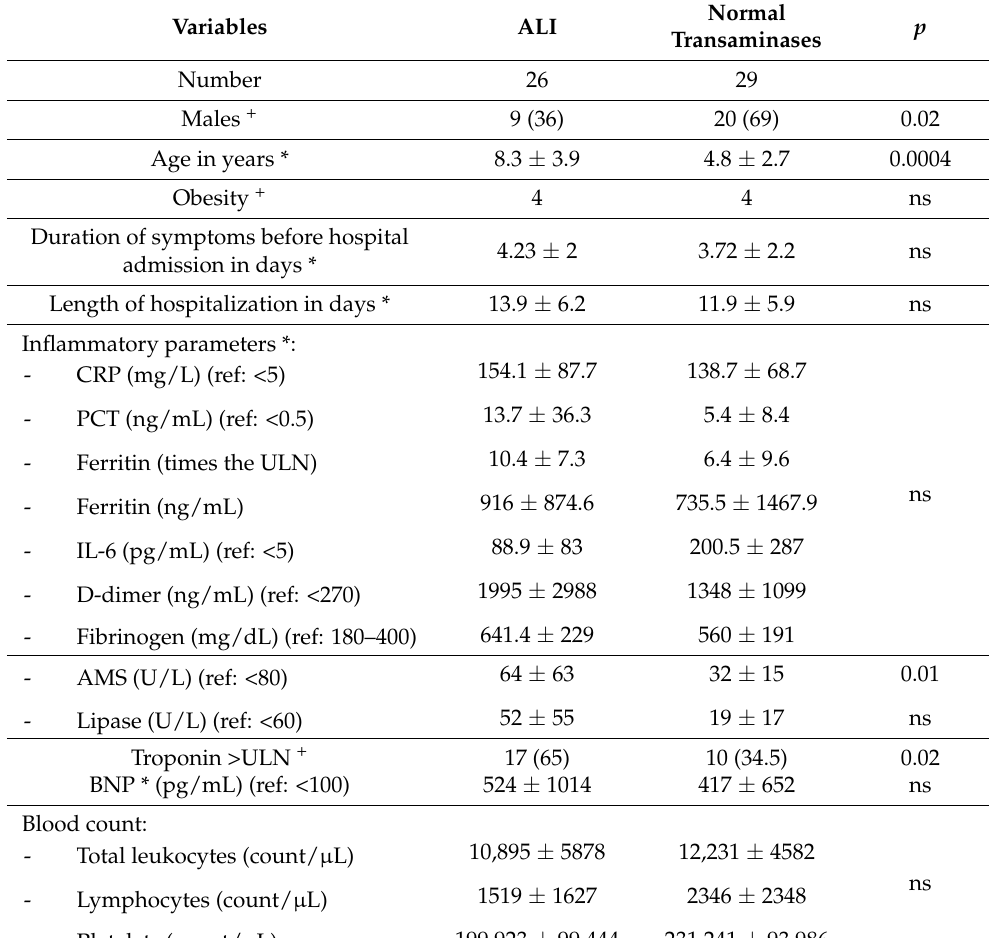
Table 2. Baseline characteristics of patients with MIS-C with and without ALI. Variables ALI